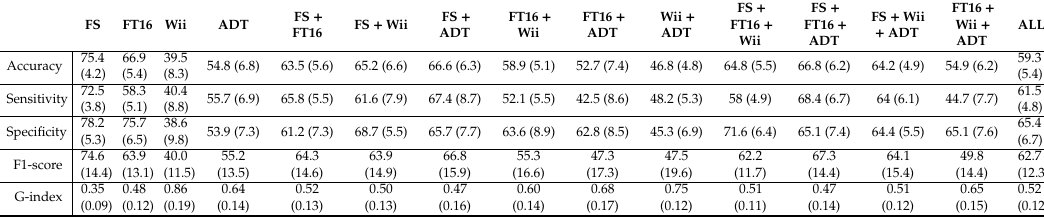
Table 4. SVM accuracy, sensitivity, specificity, F1-score, and G-index for high vs. low-medium classification considering di ff erent feature sets including full signal (FS), which was the processed signal of IMU (inertial measurement units), 16 features from that signal (FT16), the output of balance board (Wii), and finally HADS (Hospital Anxiety Depression Scale) and TSK (Tampa Scale of Kinesiophobia) questionnaire data (ADT). The reported numbers are in the format of the mean (standard deviation) of the ten runs. + FT16 + Wii + + Wii FS + FS FT16 Wii ADT FS ADT Wii FT16 FS